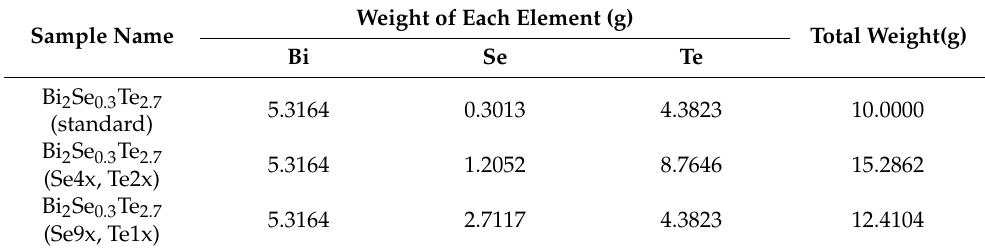
Table 2. Data to demonstrate the variation in the compositions of different n-type